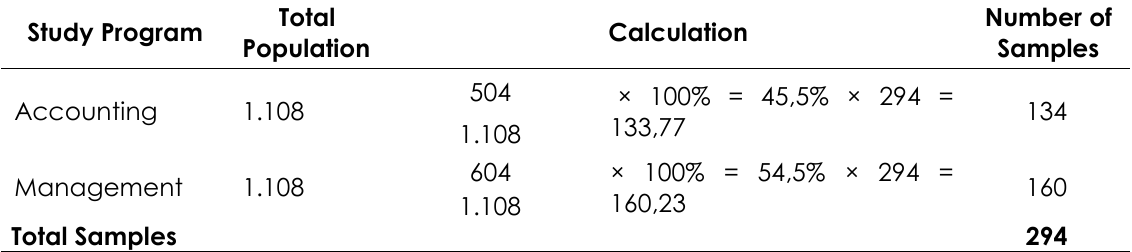
Calculation on the Number of Sub-Population